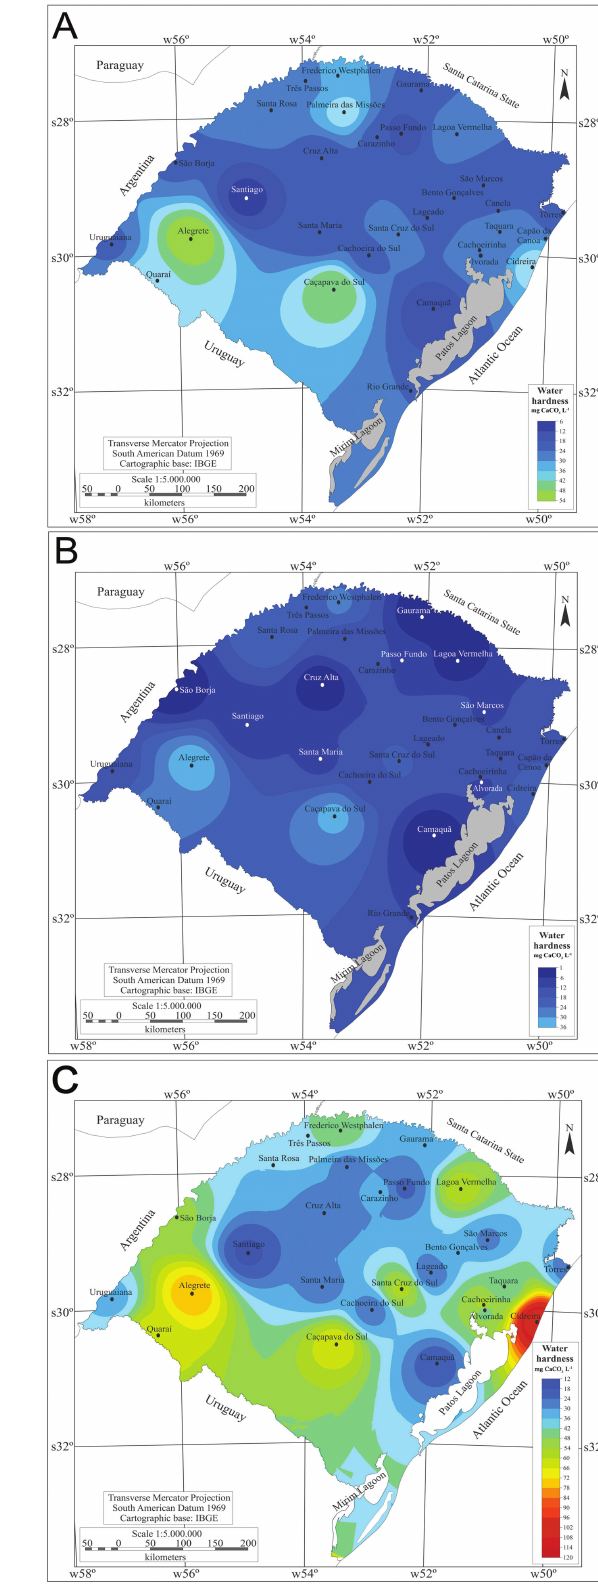
Fig. 2. Water hardness in different cities of Rio Grande do Sul in the period of 1996 to 2011 (A) mean, (B) minimum and (C) maximum values (Source